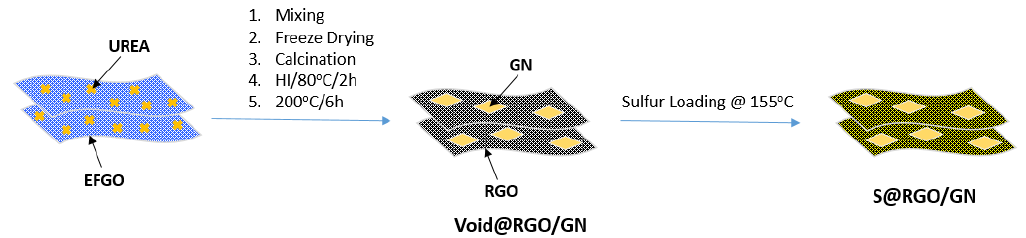
Figure 1. Schematic diagram of the synthesis of S@RGO/GN cathode.